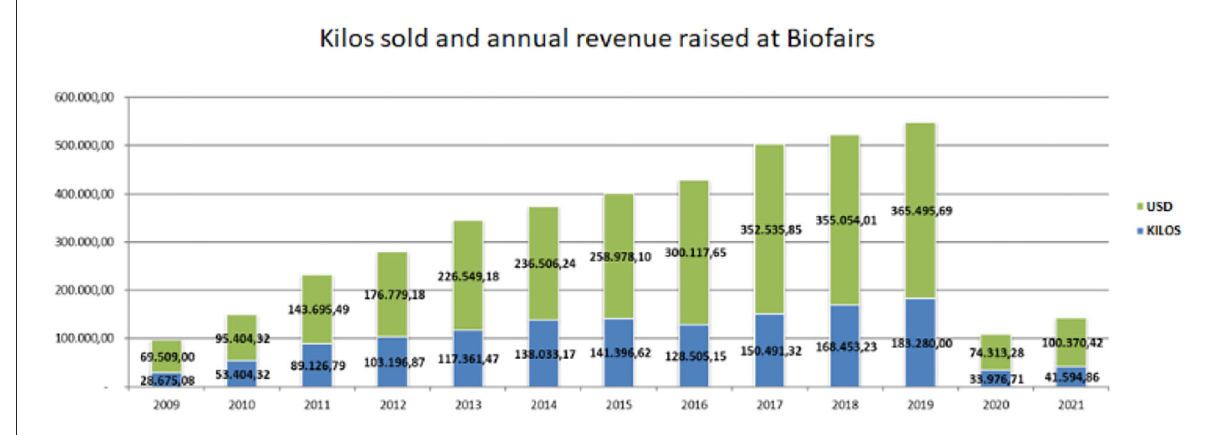
FIGURE1 Income per Bio-fair per year. Source: AGRUPAR’s census 2020.